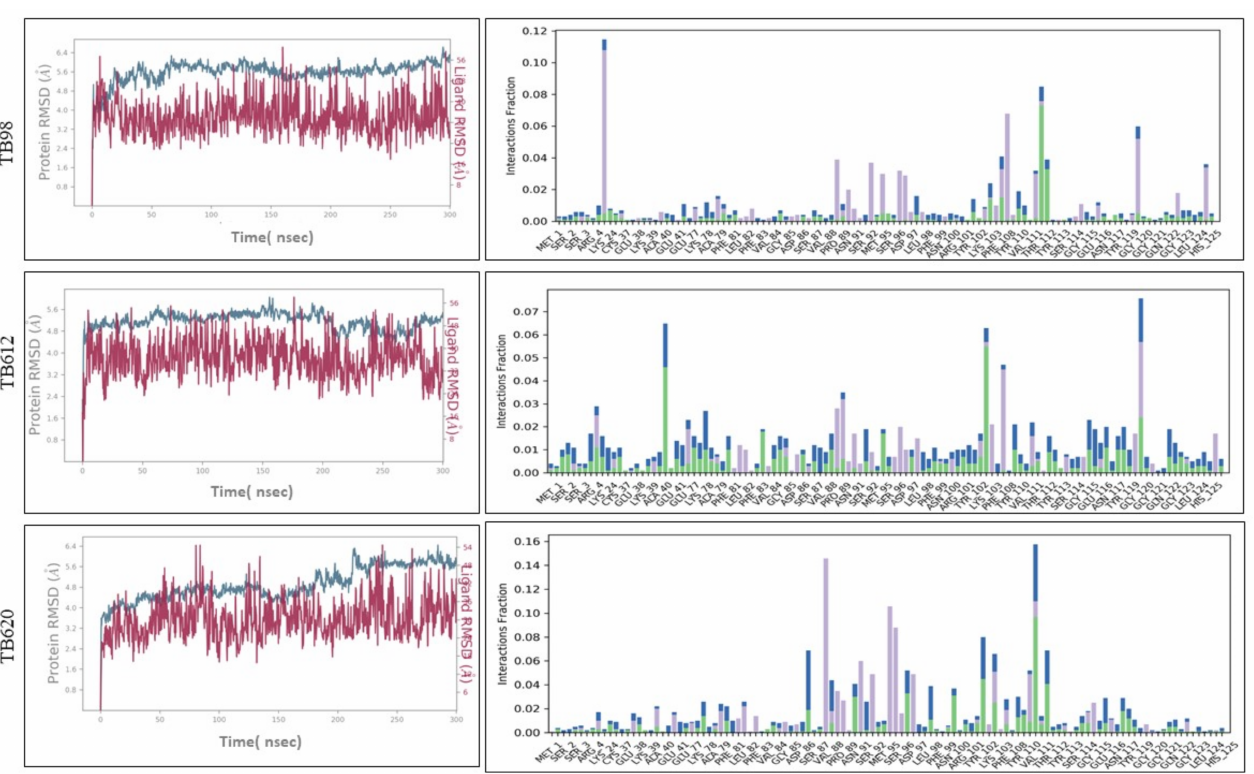
Figure 9. Root Mean Square Deviation (RMSD) Plots and Protein-Ligand Interaction Plots of ATG8 and top three shortlisted Thiabendazole